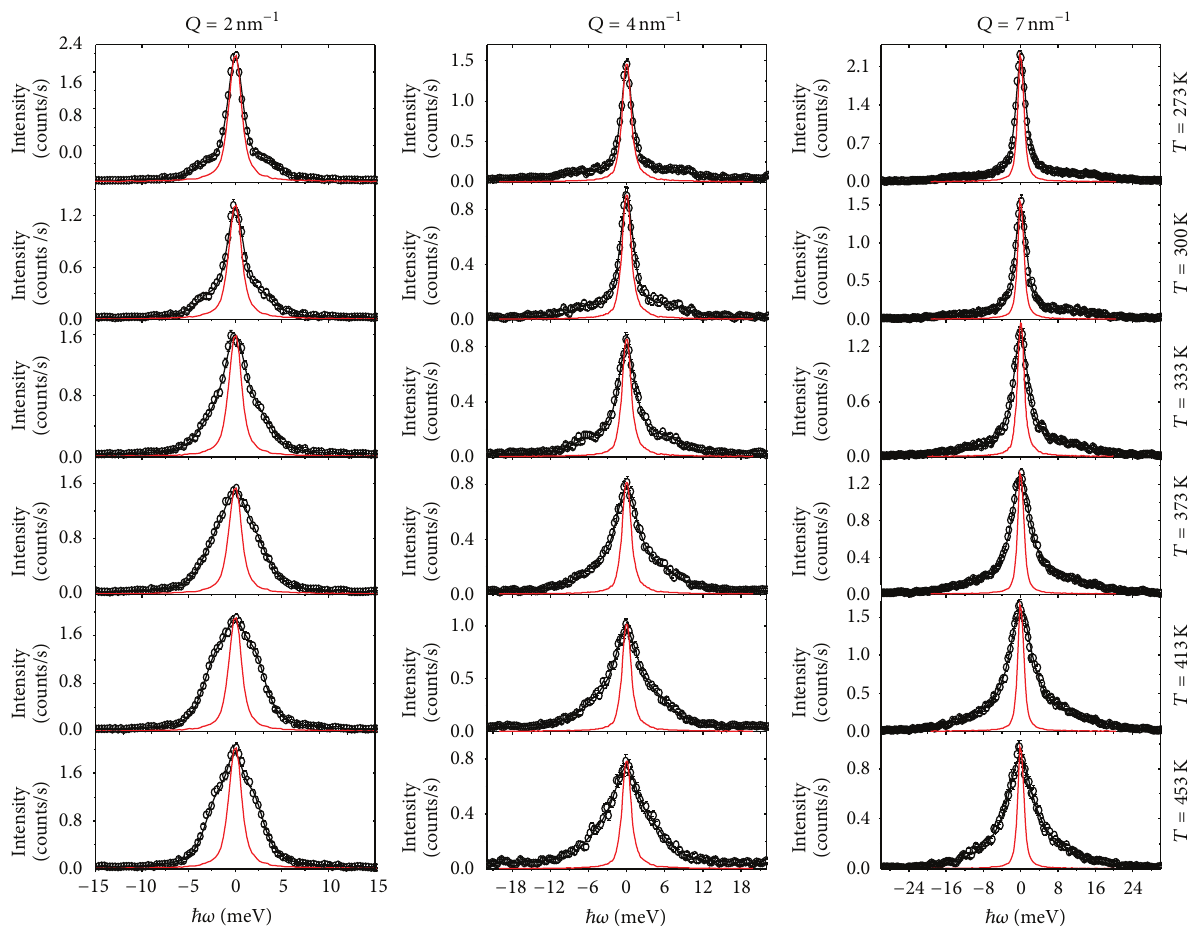
Figure 9: Typical IXS spectra measured in liquid water at the indicated temperatures and exchanged momenta (open circles). The measurements are compared with the fits performed with the experimental resolution function (red line), normalized to the maximum intensity of the IXS